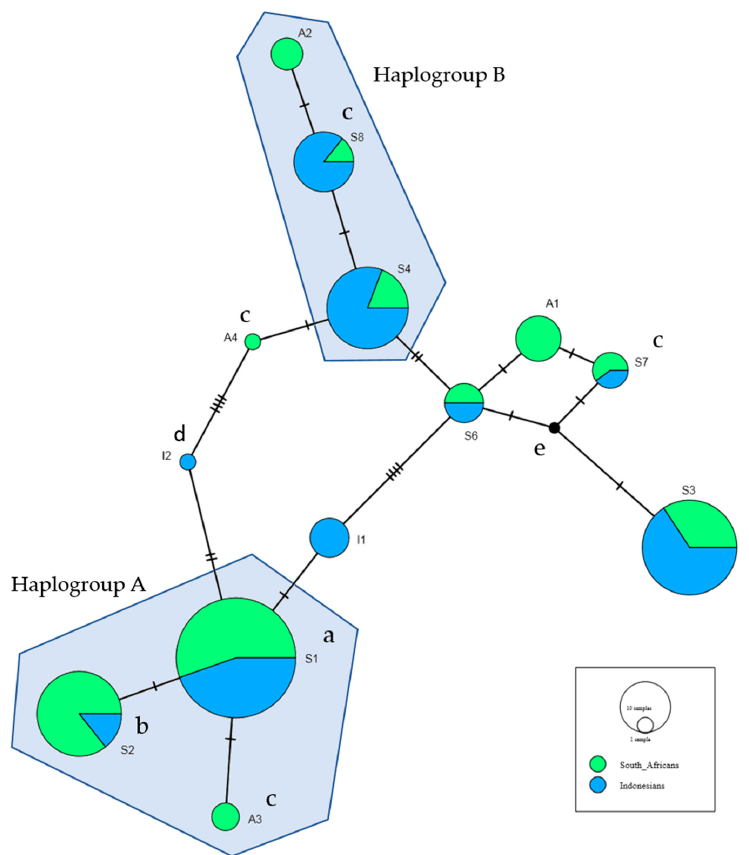
Figure 1. The haplotype network was constructed using all haplotypes which occurred in Africans and Indonesians at greater than 1%. This includes the eight shared haplotypes, four haplotypes unique to Africans and two haplotypes unique to Indonesians, as defined as in Tables 5 and 6. a Associated with increased risk of HIV-SN in Africans in bivariate analyses (Table 6). b Associated with increased risk of HIV-SN in Indonesians in bivariate analyses (Table 5). c Haplotypes not found in Africans with HIV-SN. d Haplotypes not found in Indonesians with HIV-SN. e Median vector: hypothetical haplotype automatically generated for maximum parsimony.